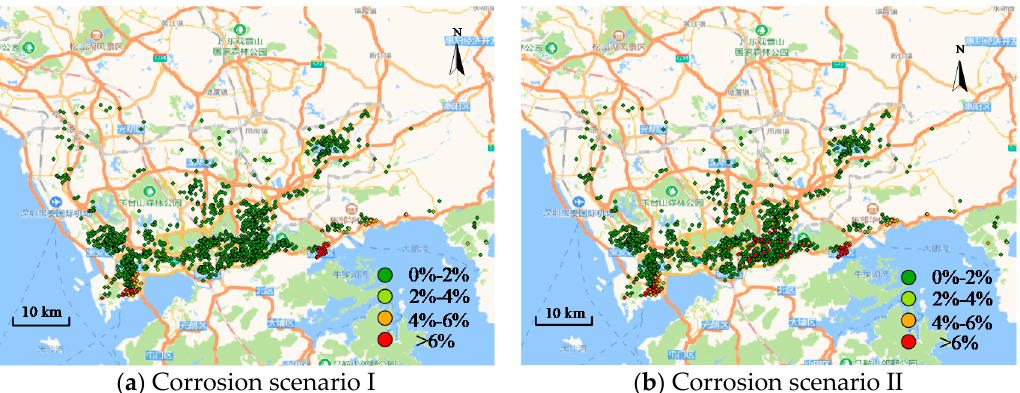
Figure 13. Simulated distributions of degree of corrosion for RC frame buildings in Shenzhen city: ( a ) Corrosion scenario I; ( b ) Corrosion scenario II.